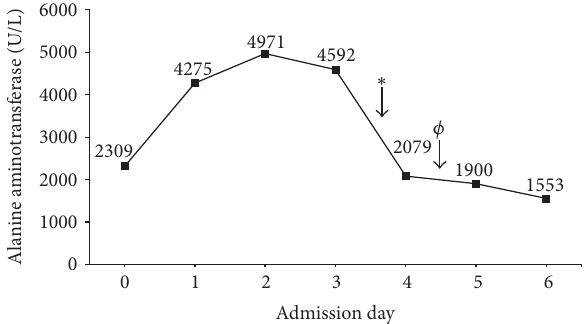
Figure 1: Alanine aminotransferase (ALT) levels during hospital admission in relation to medical therapy. Solumedrol initiation is denoted by ∗ while initiation of Acyclovir is indicated by 𝜙